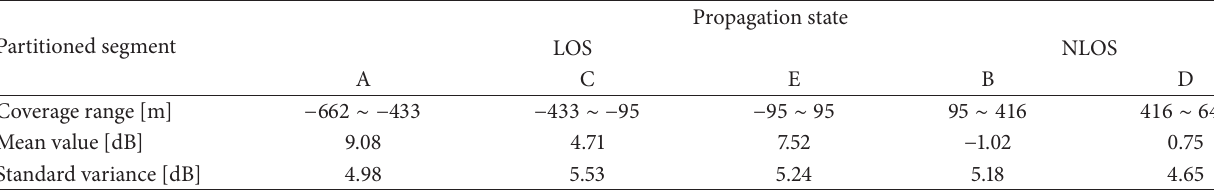
Table 1: The 𝐾 -factor results in different propagation segments.